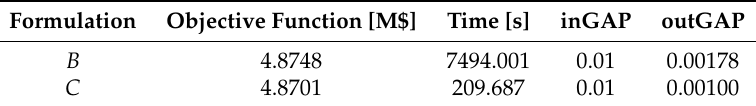
Table 4. Results obtained for scaled test